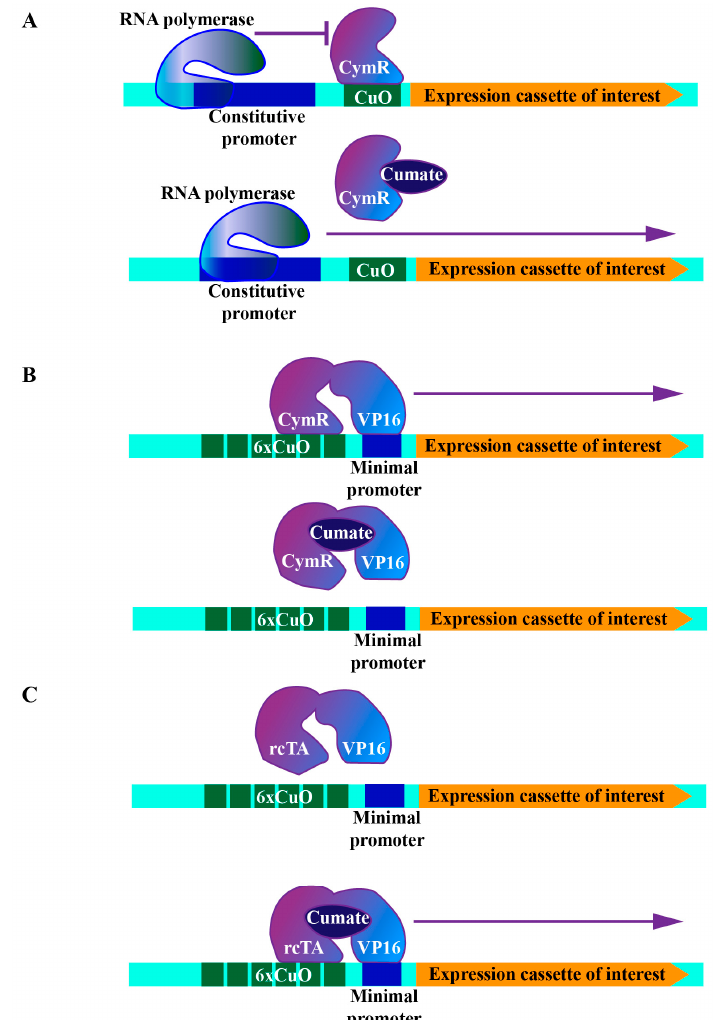
Figure 2. Schematic representations of cumate-controlled operator systems. ( A ) Repression configuration. ( B ) Activator configuration. ( C ) Reverse activator configuration. CymR: cumate repressor, CuO: cumate operator, rcTA: reverse chimeric transactivator.